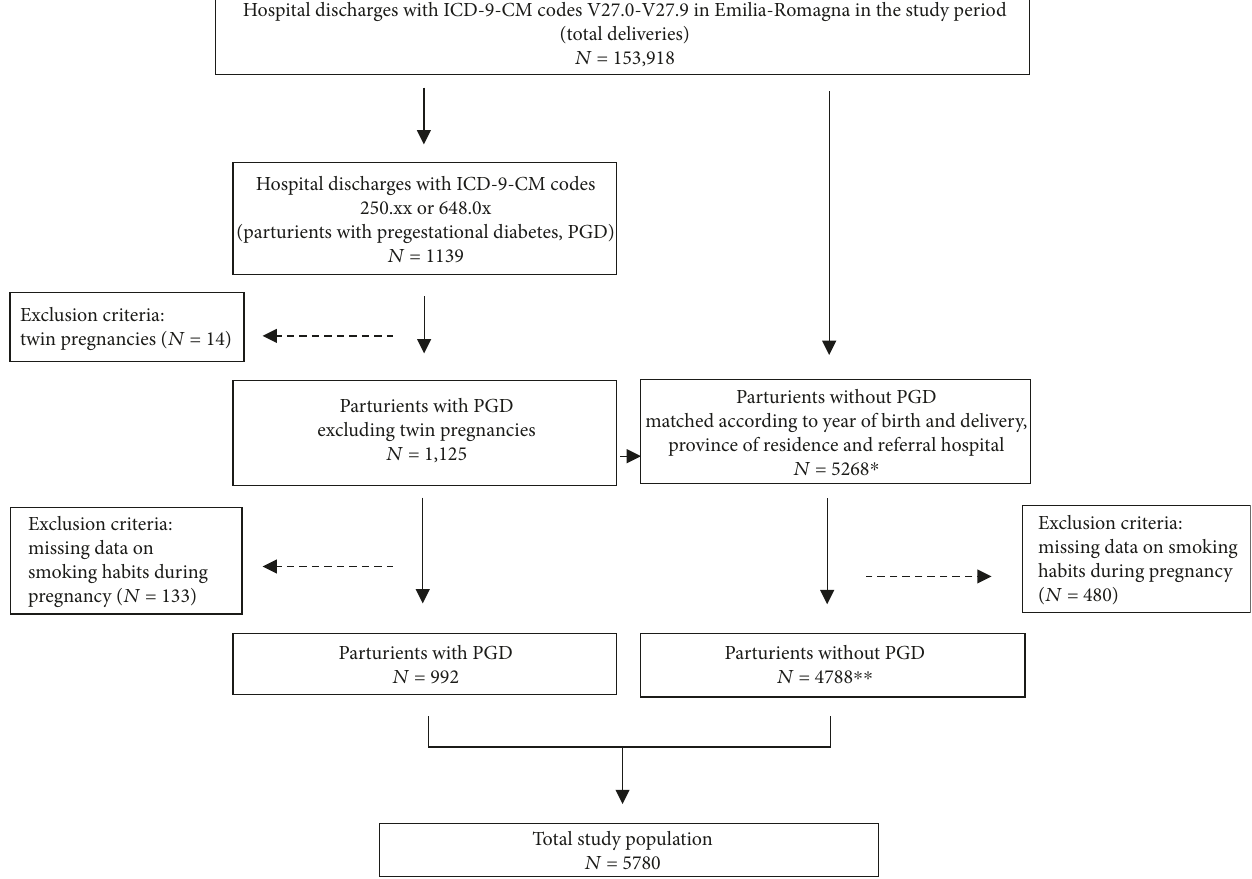
Figure 1: Flowchart of the study population. ∗ 954 cases matched 5 controls, 66 cases matched 4 controls, 49 cases matched 3 controls, 31 cases matched 2 controls and 25 cases matched 1 control. ∗∗ 921 cases matched 5 controls, 22 cases matched 4 controls, 17 cases matched 3 controls, 12 cases matched 2 controls and 20 cases matched 1